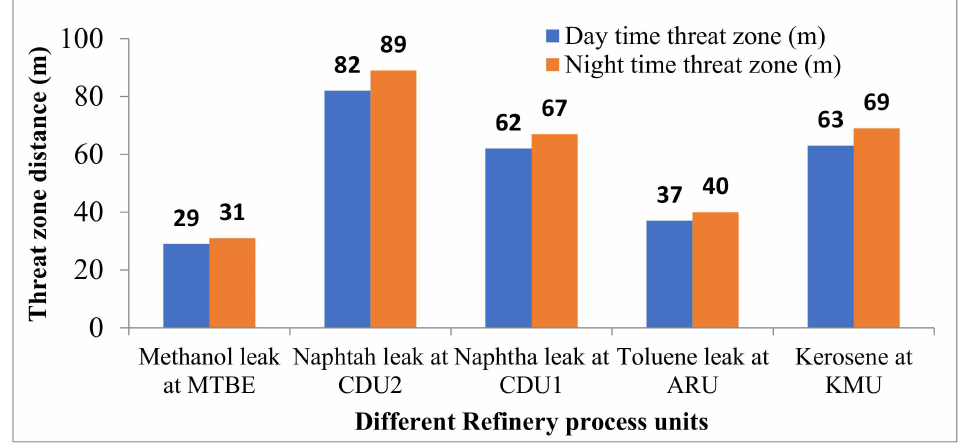
Figure 6. Threat zones for fireball radiations.